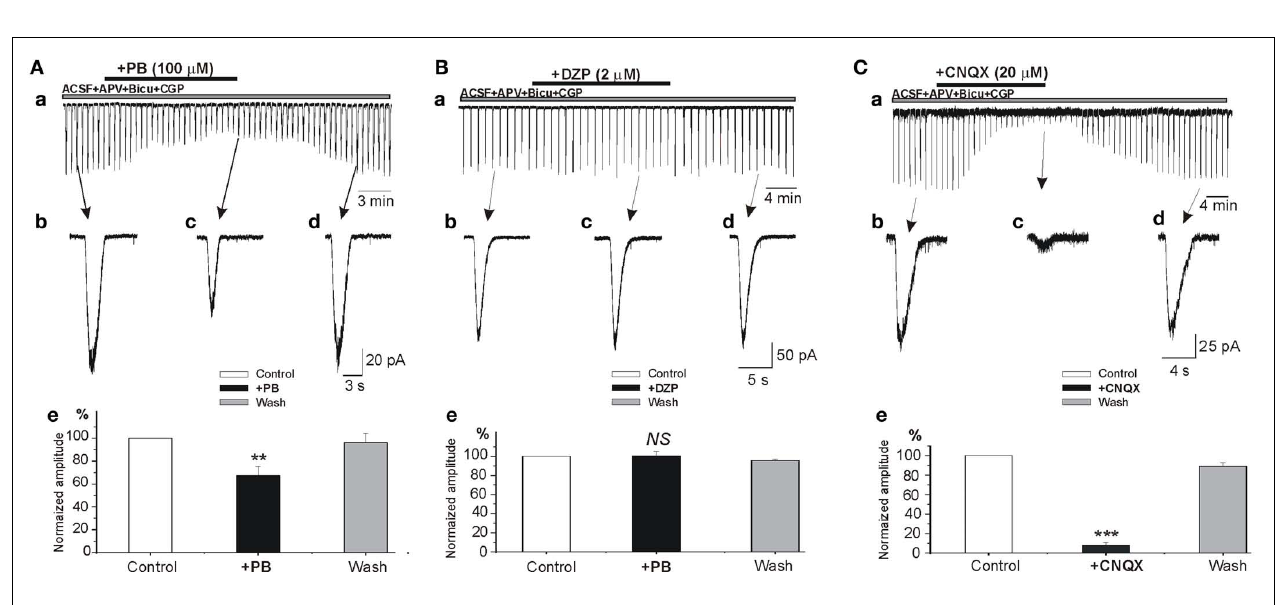
glutamate induced currents showing the effects of PB (Ae) , DZP (Be) , and CNQX (Ce) . Note that phenobarbital but not diazepam significantly reduced the amplitude AMPA/kainate receptor mediated postsynaptic currents (67.2 ± 8.1%, p < 0.001, n = 4). NS, not statistically significant.